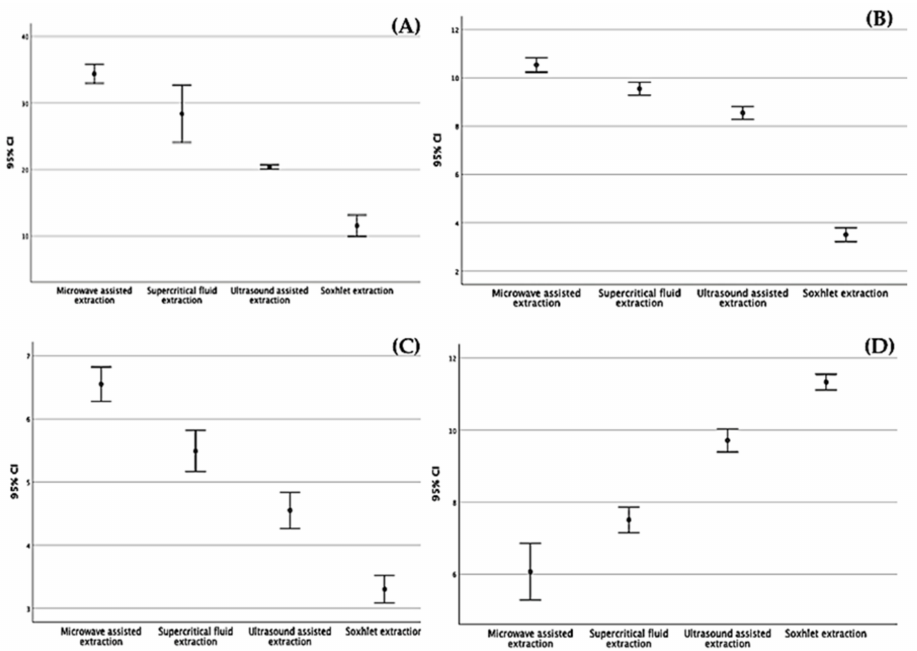
Figure 5. The 95% confidence intervals for the main analysis of ( A ) total phenols, ( B ) total flavonoids,